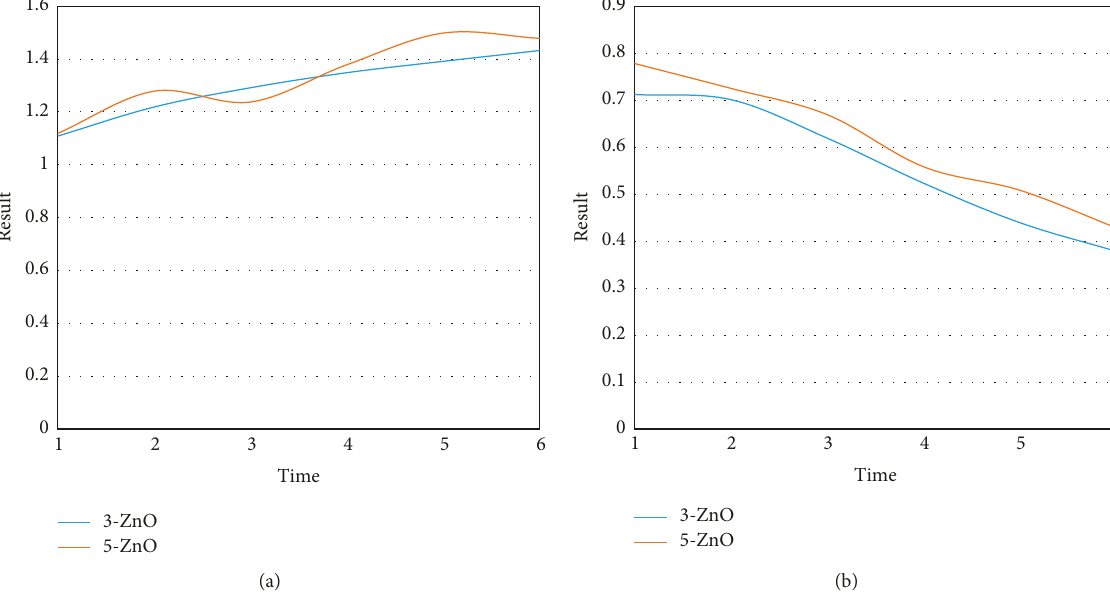
Figure 7: Fusion rate and degradation rate of particles at different times.